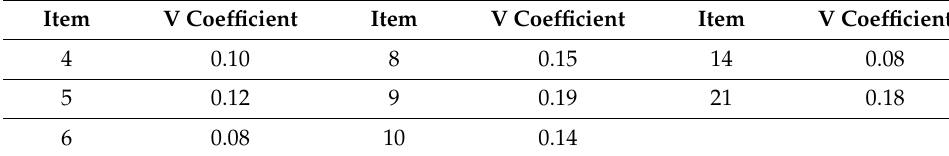
Table 5. Items Assessing Speed Skaters’ Sport Psychological